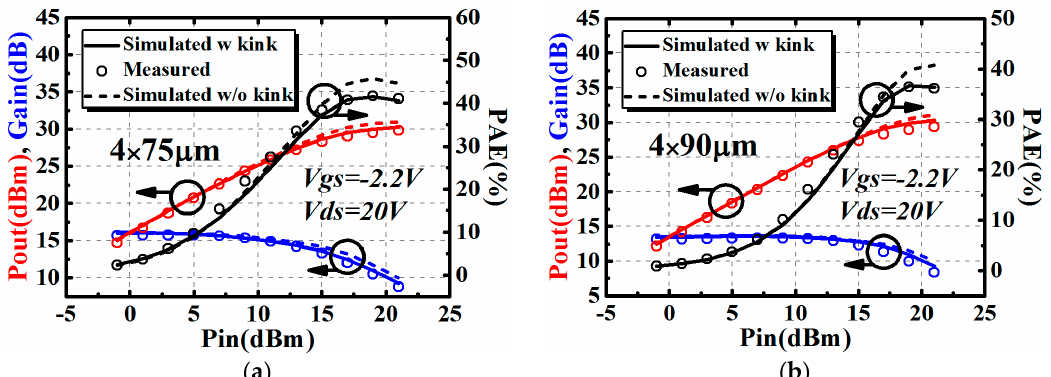
Figure 7. The influence brought by the I–V kink effect on large signal performance of AlGaN/GaN HEMTs @10GHz: ( a ) 4 × 75 μ m and ( b ) 4 × 90 μ m.